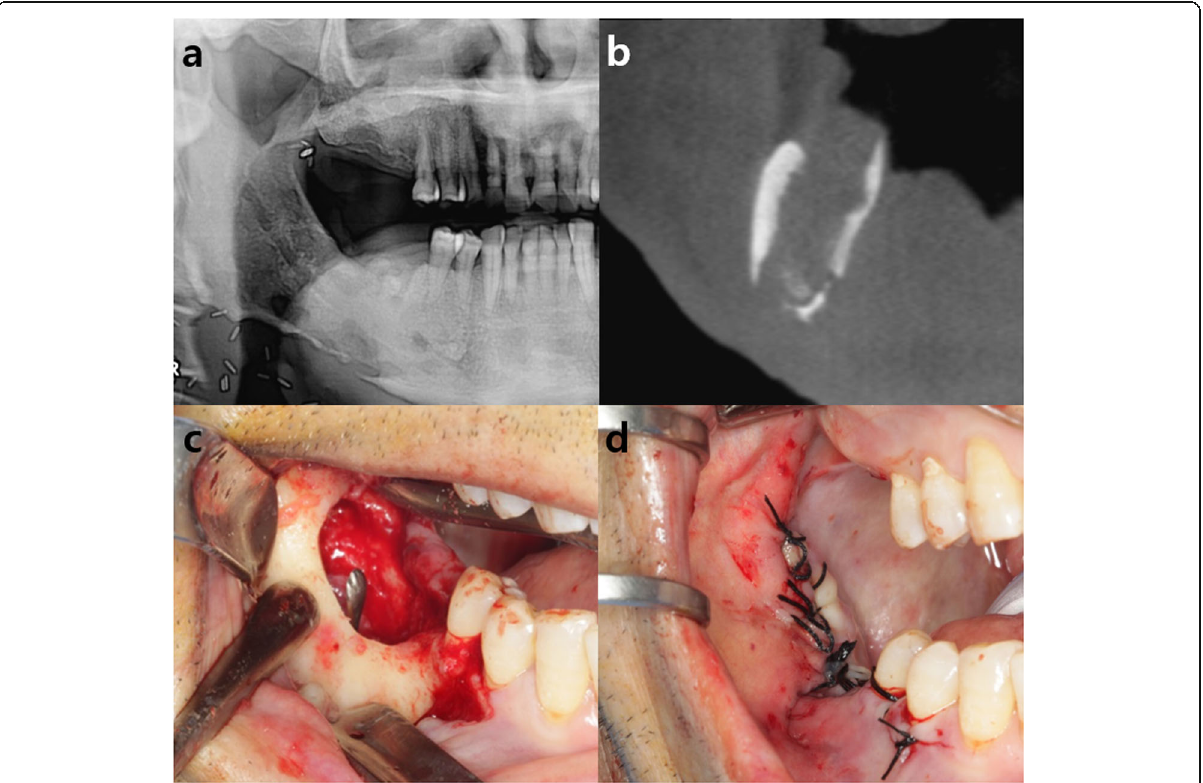
Fig. 1 a , b Preoperative panoramic view and CT view showing partial osteonecrosis on the right mandibular body and angle. c Intra-oral photograph showing communicated fistulas on the intra- and extra-oral cavity after sequestrectomy via intra-oral approach. d The communicated fistulas on the intra- and extra-oral cavity were sutured for primary